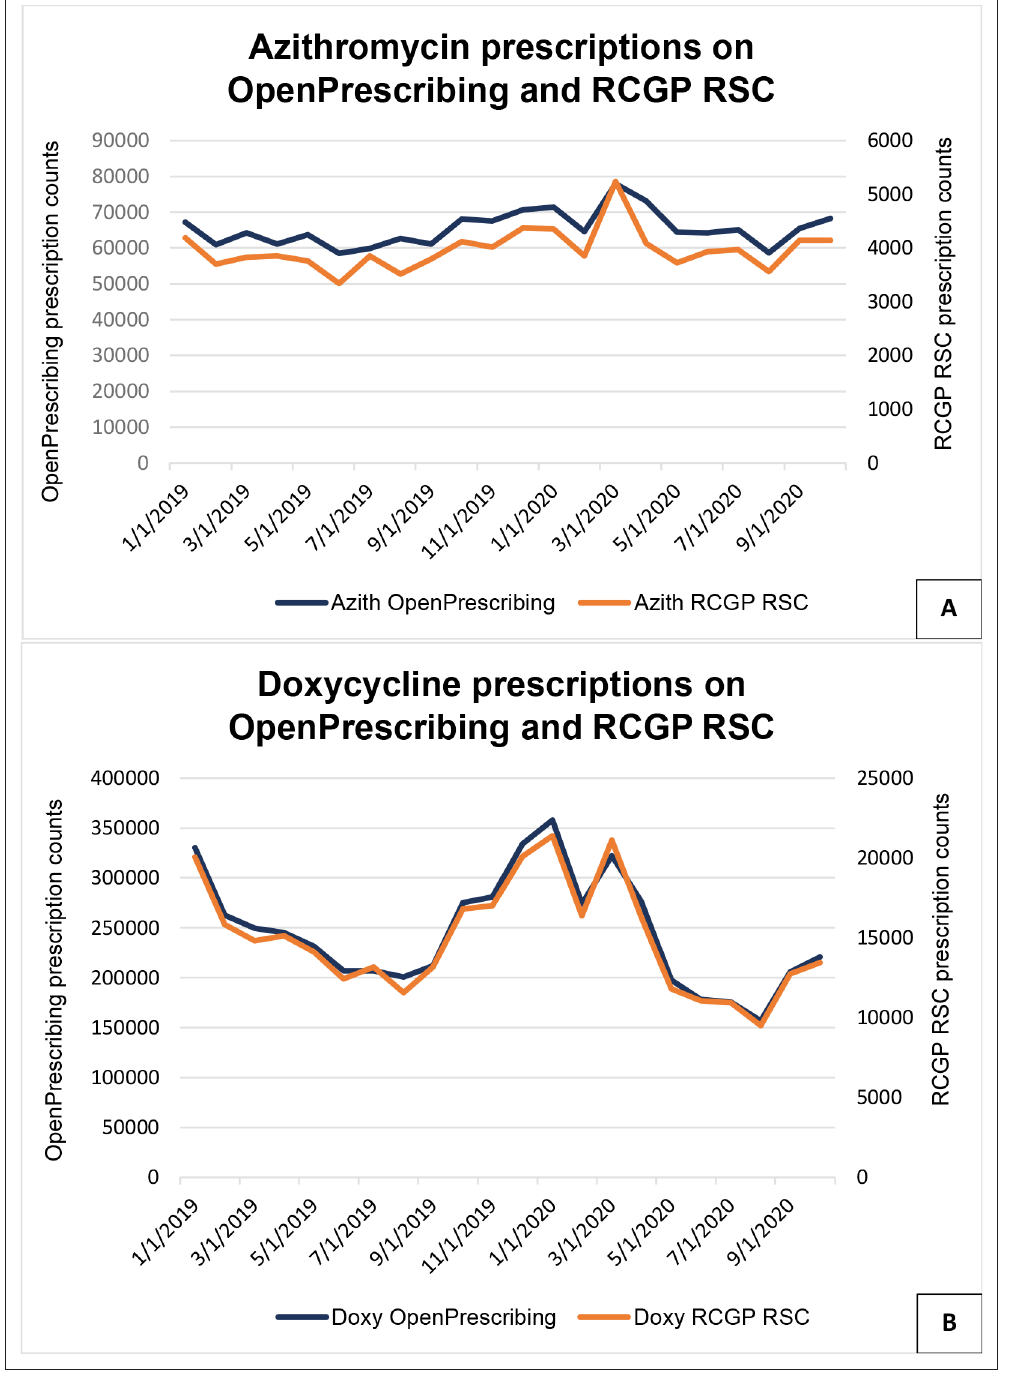
Azith = azithromycin. Doxy = doxycycline. RCGP RSC = Royal College of General Practitioners Research and Surveillance